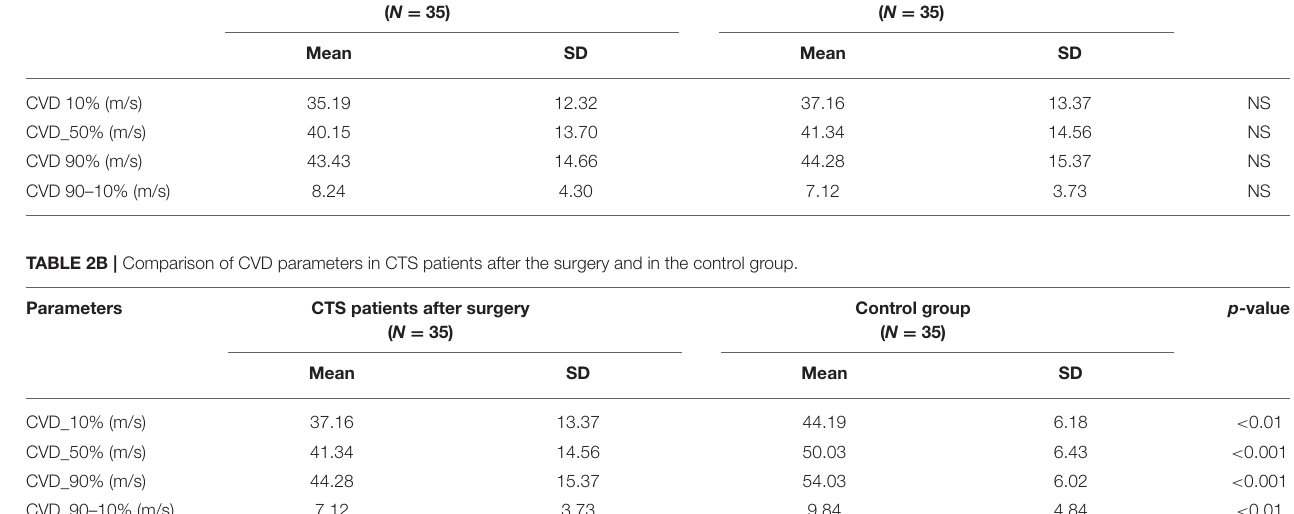
TABLE 2A | Mean values of CVD test before and after surgery in CTS patients. Parameters